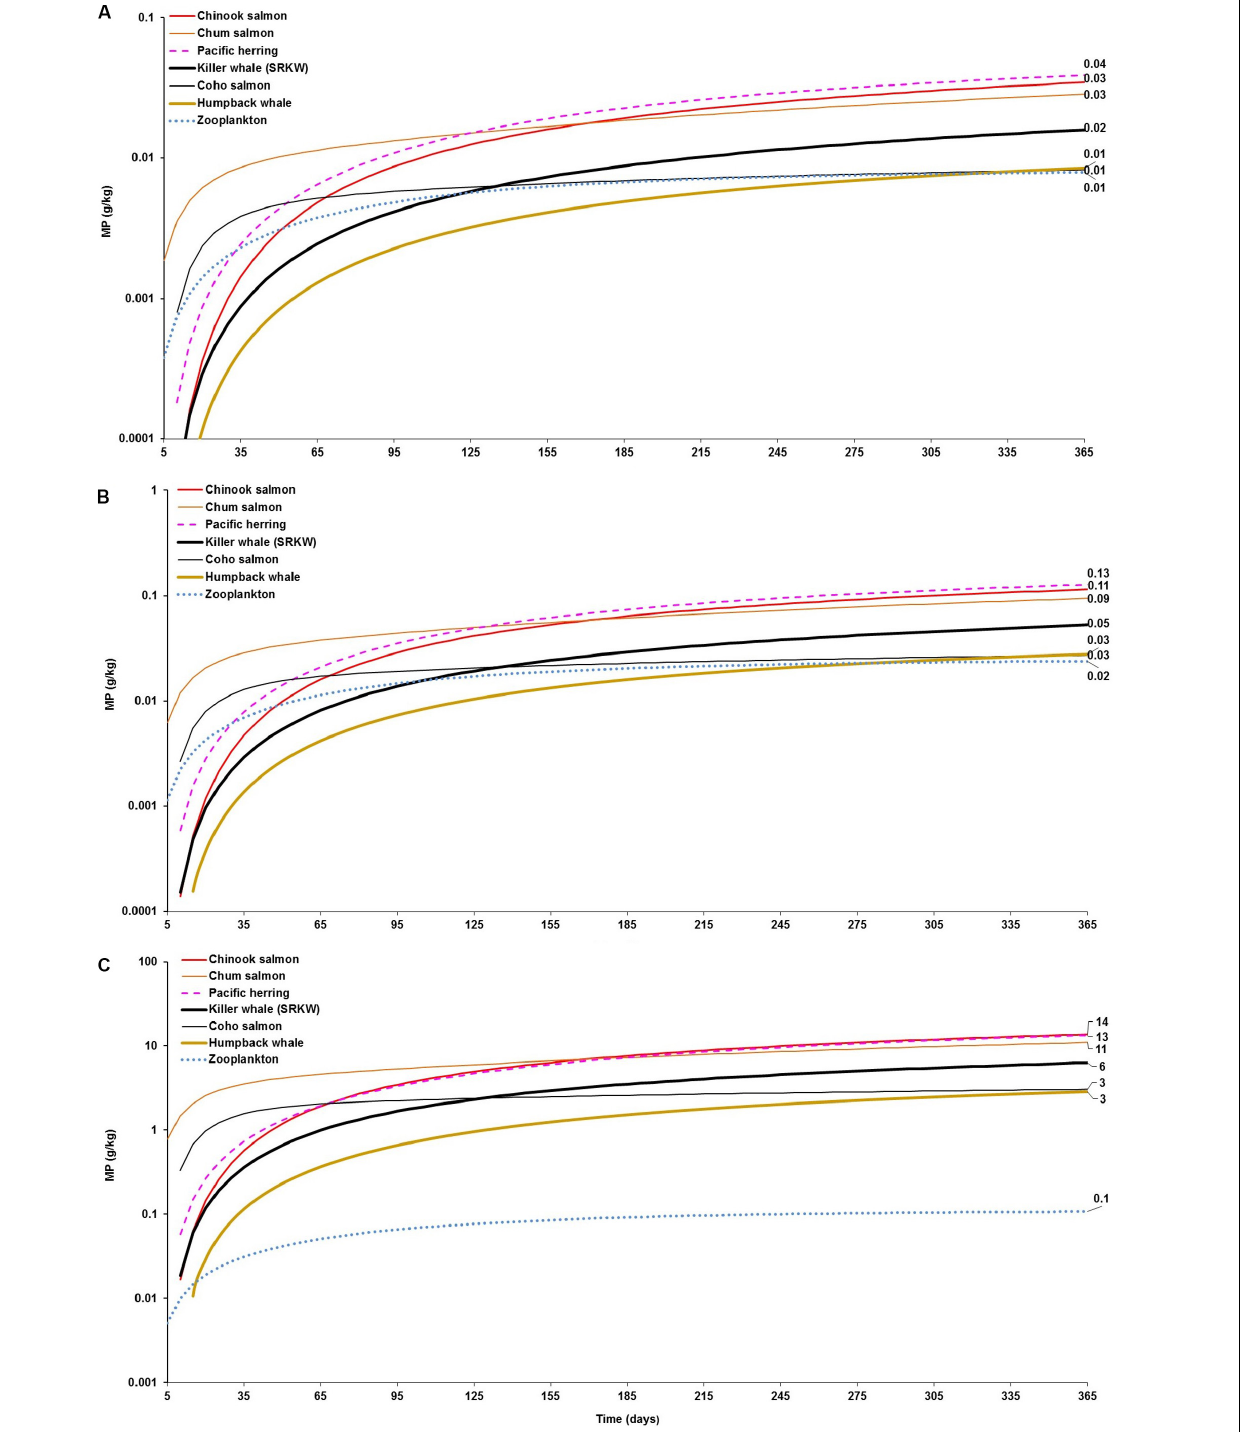
Frontiers in Marine Science |